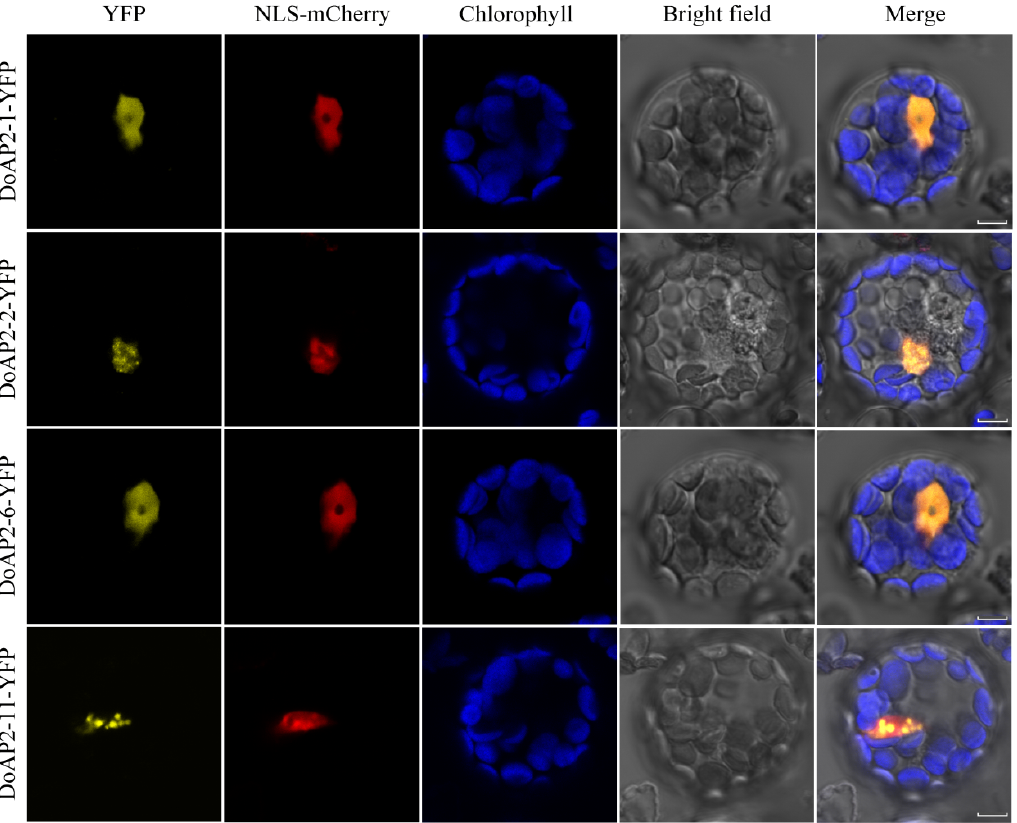
Figure 7. Subcellular localization of four DoAP2 proteins (DoAP2-1, DoAP2-2, DoAP2-6 and DoAP2-11) in A. thaliana protoplasts. Bars = 5 μm.